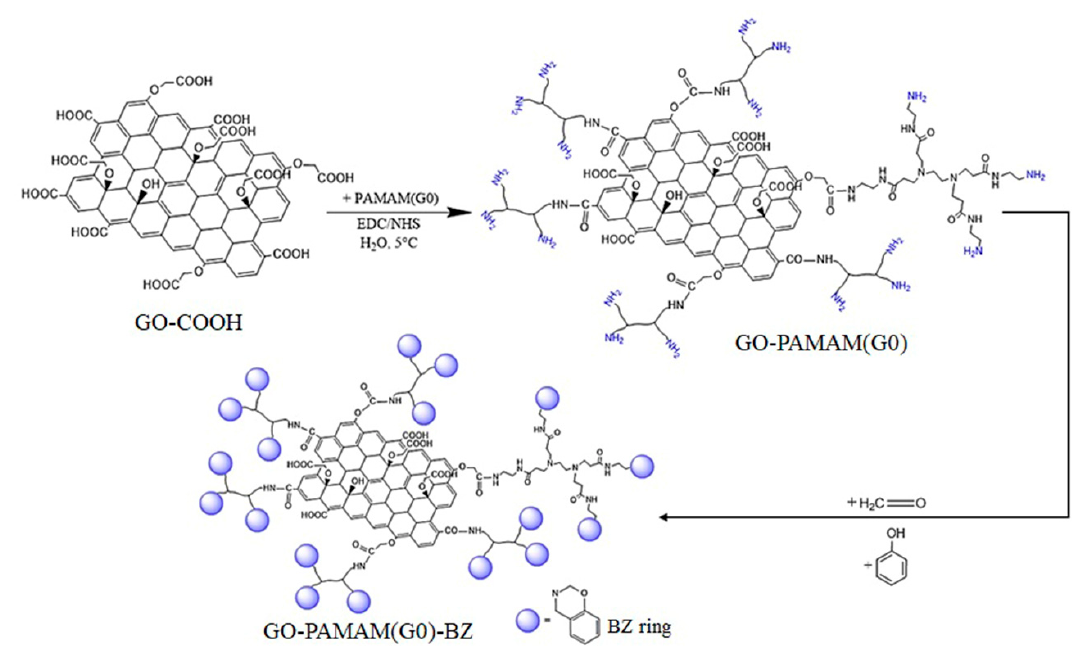
Figure 2. The functionalization route of GO-COOH with multiple benzoxazine rings .